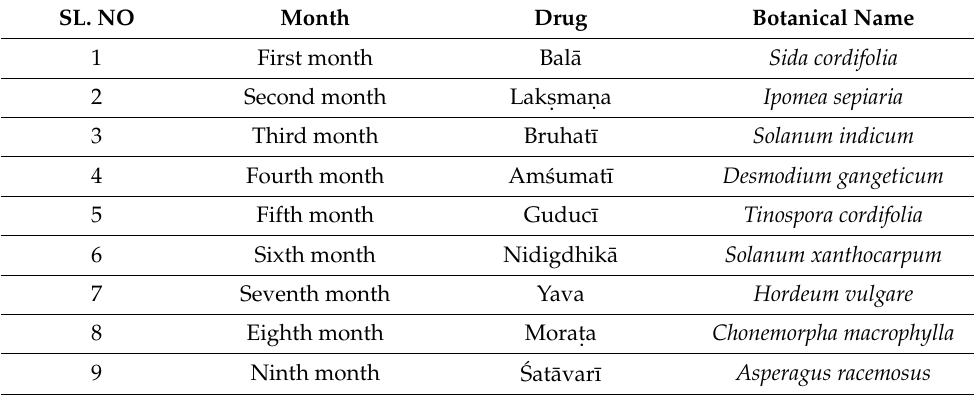
Table 2. Month wise drugs for medicated